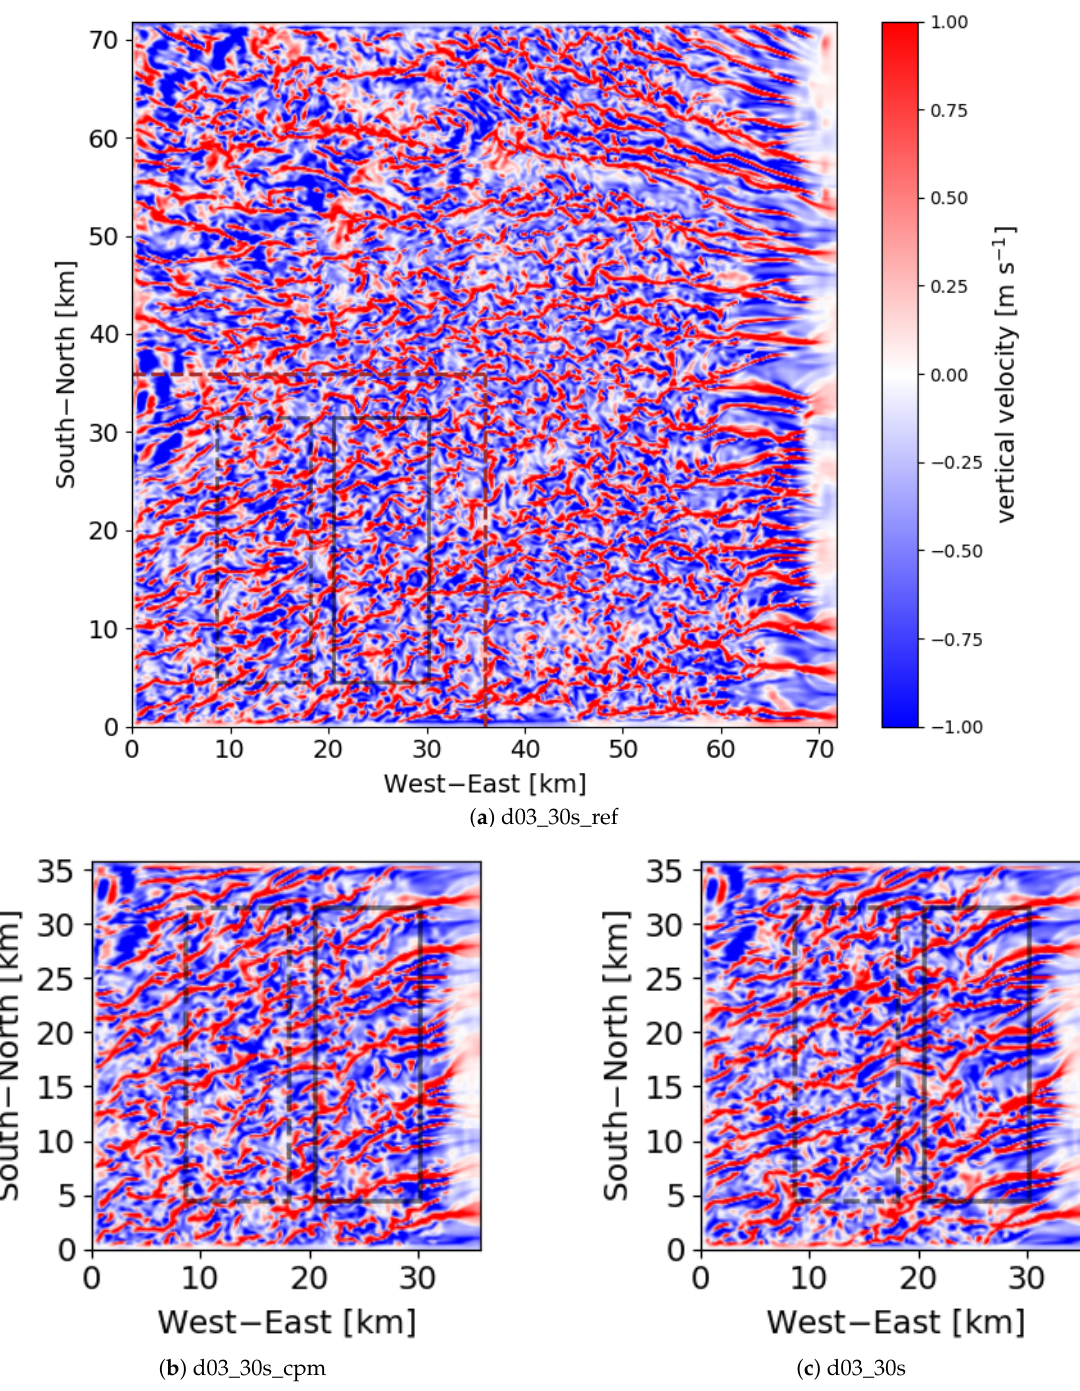
Figure 13. As in Figure 9 but at 1115 UTC 20 May